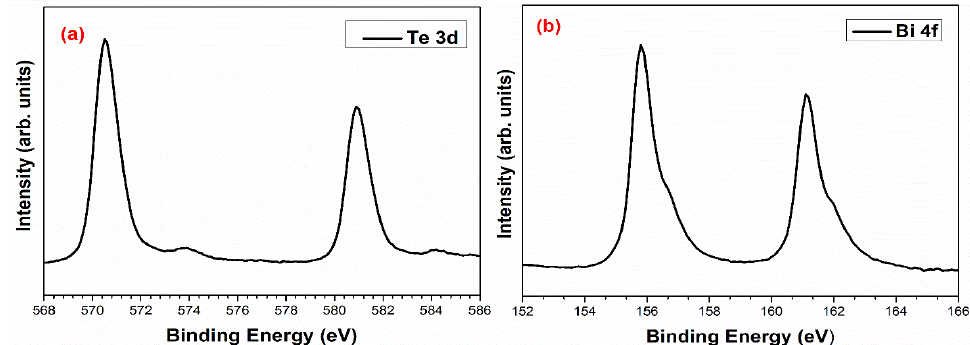
Figure 7. XPS spectra for ( a ) Te 3d and, ( b ) Bi 4f of synthesized Bi 2 Te 3 thin film.